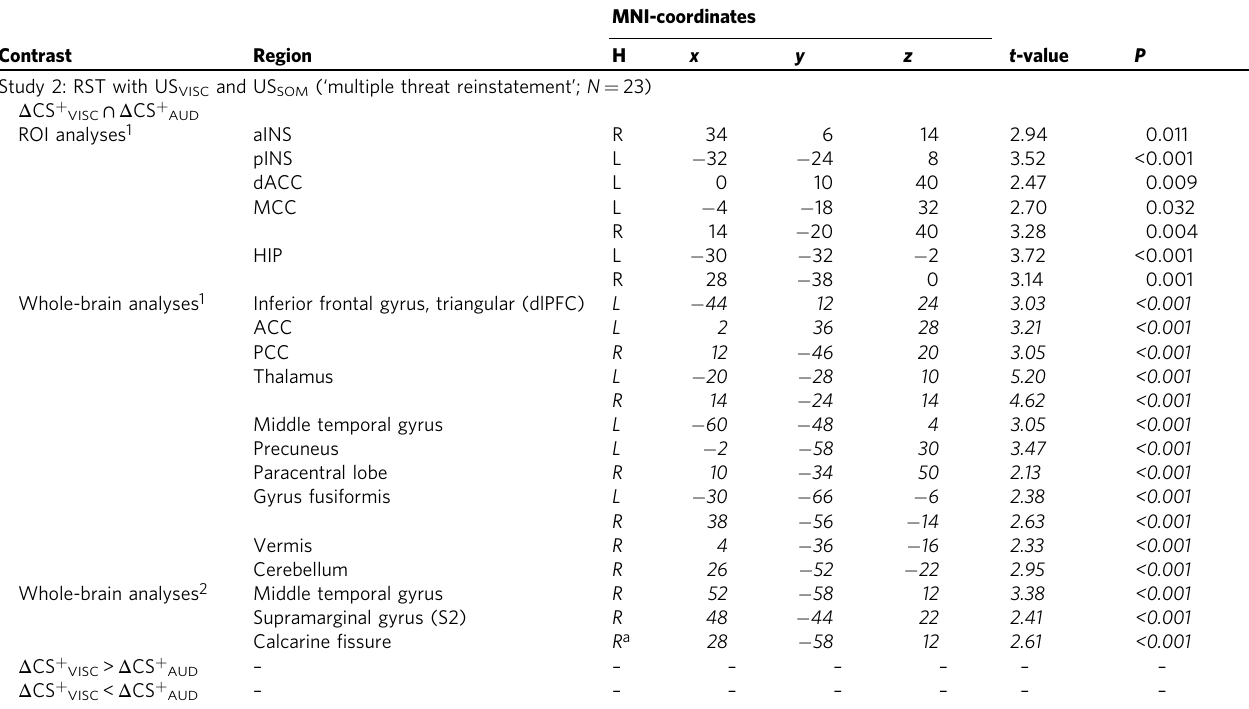
Sharedanddifferentialneuralactivationinducedbypredictorsofinteroceptive(CS + VISC )andexteroceptivethreat(CS + AUD )relativetosafety-predictiveCS − ,duringreinstatement-test(RST-TEST)after multiple threat reinstatement with US VISC and US AUD . For shared activation, results of conjunction analyses against global null are presented ( 1 {CS + VISC >CS − } ∩ {CS + AUD >CS − }; 2 {CS + VISC <CS − } ∩ {CS + AUD <CS − }). For differential activation, results of second-level paired t -tests are presented ({CS + VISC <CS − }>{CS + AUD <CS − }; and vice versa). Peak voxel indicates results of ROI analyses (cluster size k E ≥ 3; all P FWE <0.05) and whole-brain analyses ( in italic font ; cluster size k E ≥ 10; all P uncorrected <0.001). Exact unilateral P -values are provided. For a visualisation, see Fig. 3 and Supplementary Fig. S7. aINS anterior insula, CS conditioned stimuli, FWE family-wise error, dACC dorsalanterior cingulatecortex, dlPFC dorsolateralprefrontalcortex, H hemisphere, HIP hippocampus, MCC midcingulatecortex, MNI Montreal Neurological Institute, pINS posterior insula, ROI regions of interest, S2 secondary somatosensory cortex, VISC visceral. a Results also signi fi cant against conjunction